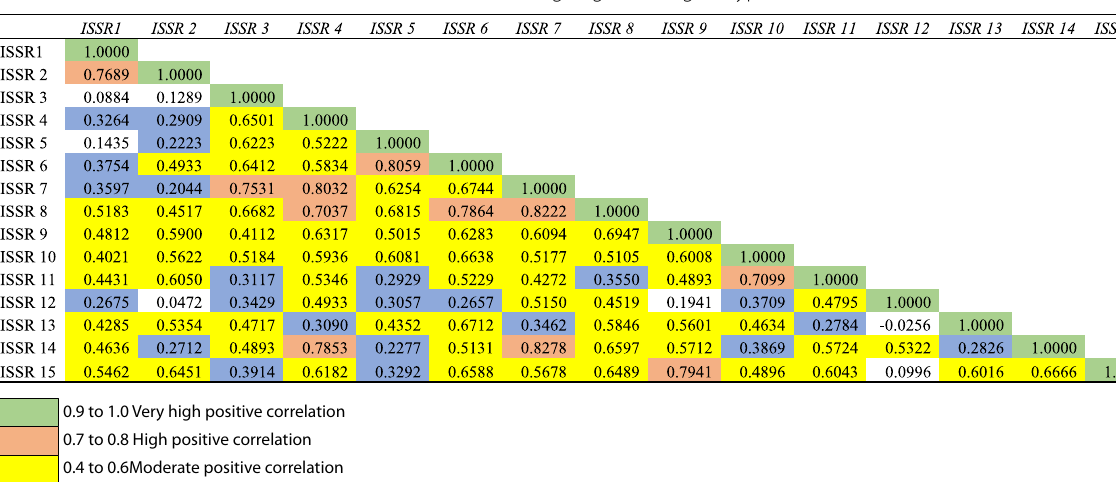
Table 5 Correlation coefficient of different ISSR markers among finger millet genotypes